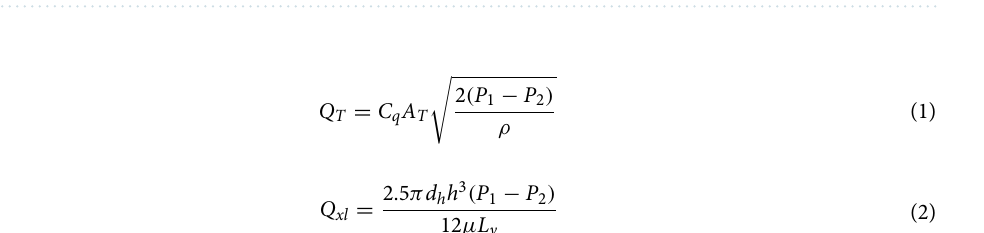
Figure 1. Hydraulic shock